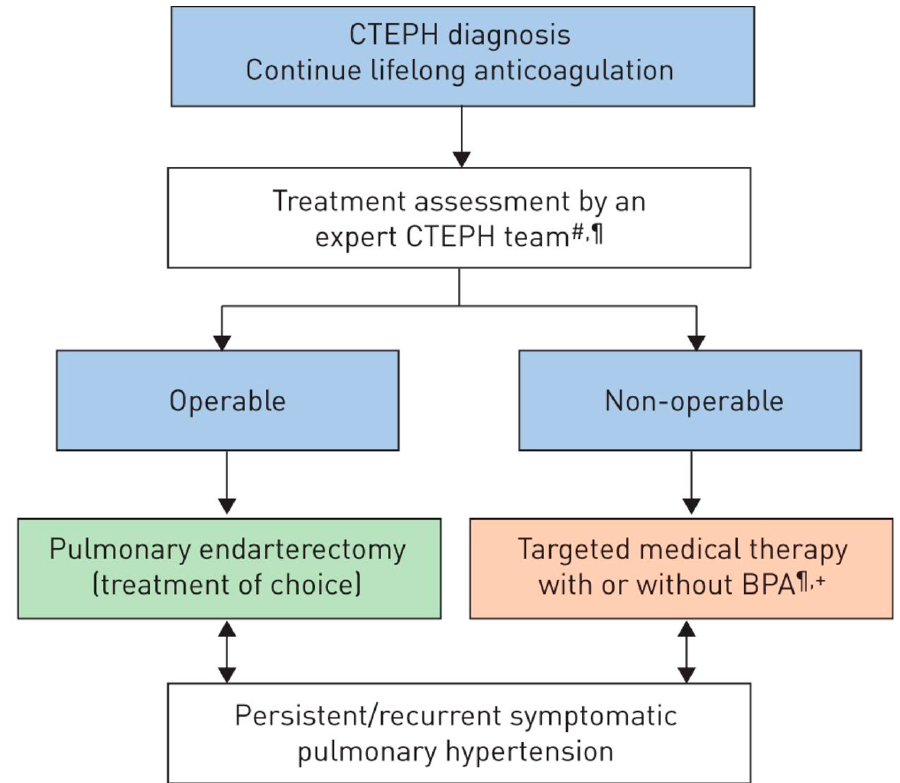
Figure 2. Chronic thromboembolic pulmonary hypertension (CTEPH): revised treatment algorithm. BPA: balloon pulmonary angioplasty. #: multidisciplinary: pulmonary endarterectomy surgeon, PH expert, BPA interventionist and radiologist; ¶: treatment assessment may differ depending on the level of expertise; +: BPA without medical therapy can be considered in selected cases [10]. Repro- duced with permission of the © ERS 2022: European Respiratory Journal Jan 2019, 53 (1) 1801915; DOI: 10.1183/13993003.01915-2018.